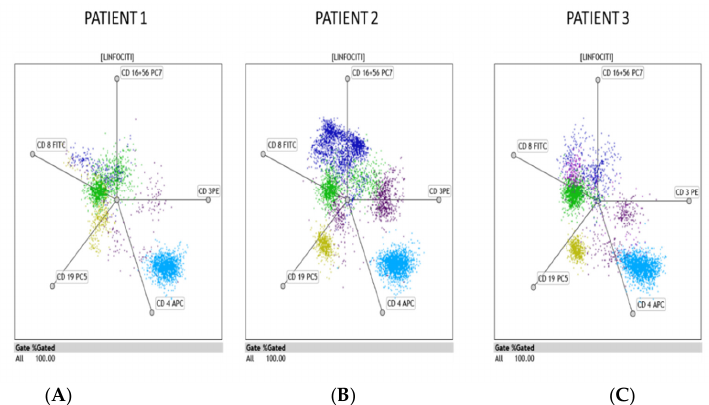
Figure 5. Distribution of the lymphocyte subpopulation and population in three covid-19 patients using the radar function of Kaluza analysis software (Beckam–Coulter). The figure shows the pattern distribution, in the electronic space, of the three major lymphocyte populations: T (CD3 + ) subdivided into CD4 + (T-helper) (cyan color) and CD8 + (T-cytotoxic) (green color), B (CD 19 + ) (ocra color), and NK (CD 16*CD 56*CD3 − ) (blue color) ( A – C ). It is of relevance that the difference in the TNK, NK, and B population practically disappeared in the first patient ( A ). In contrast, the second patient ( B ) showed a consistent presence of NK and B lymphocytes and the subdivision of the T-cytotoxic (CD3 + CD8 + ) (green) population in two different populations occupying a well-defined space in the electronic dot plot ( C ).